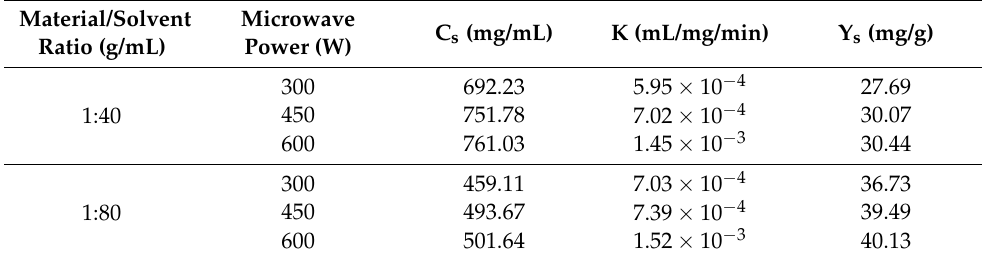
Table 2. Nonlinear regression analysis of mathematical models in antioxidant activity extraction kinetics by MAE